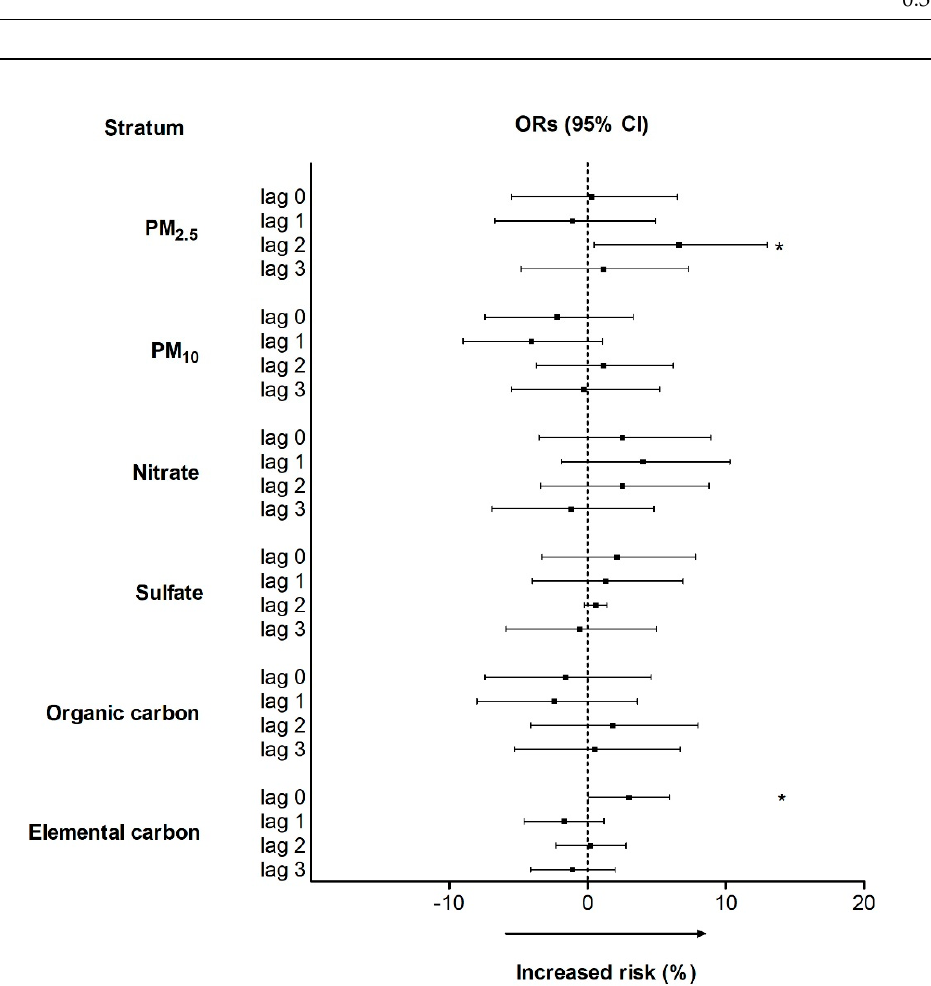
Figure 1. Odds ratios and 95% confidence intervals for COPD ED visits associated with IQR increments in PM 2.5 and its constituent levels with adjustment for temperature and humidity. COPD, chronic obstructive pulmonary disease; ED, emergency department; IQR, interquartile range. * p <